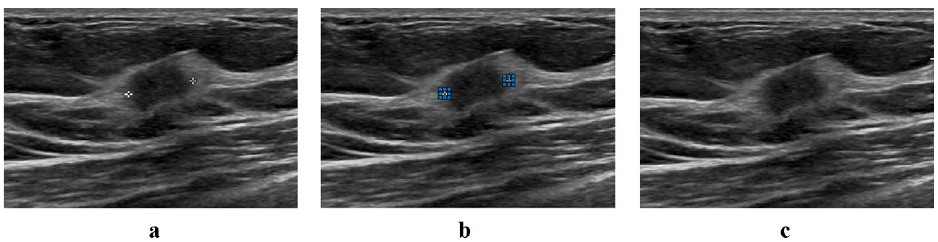
Figure 2. Ultrasound image inpainting process. Given the input image (a) and selected one or more target regions (b) , these are removed and replaced through a standard impainting technique